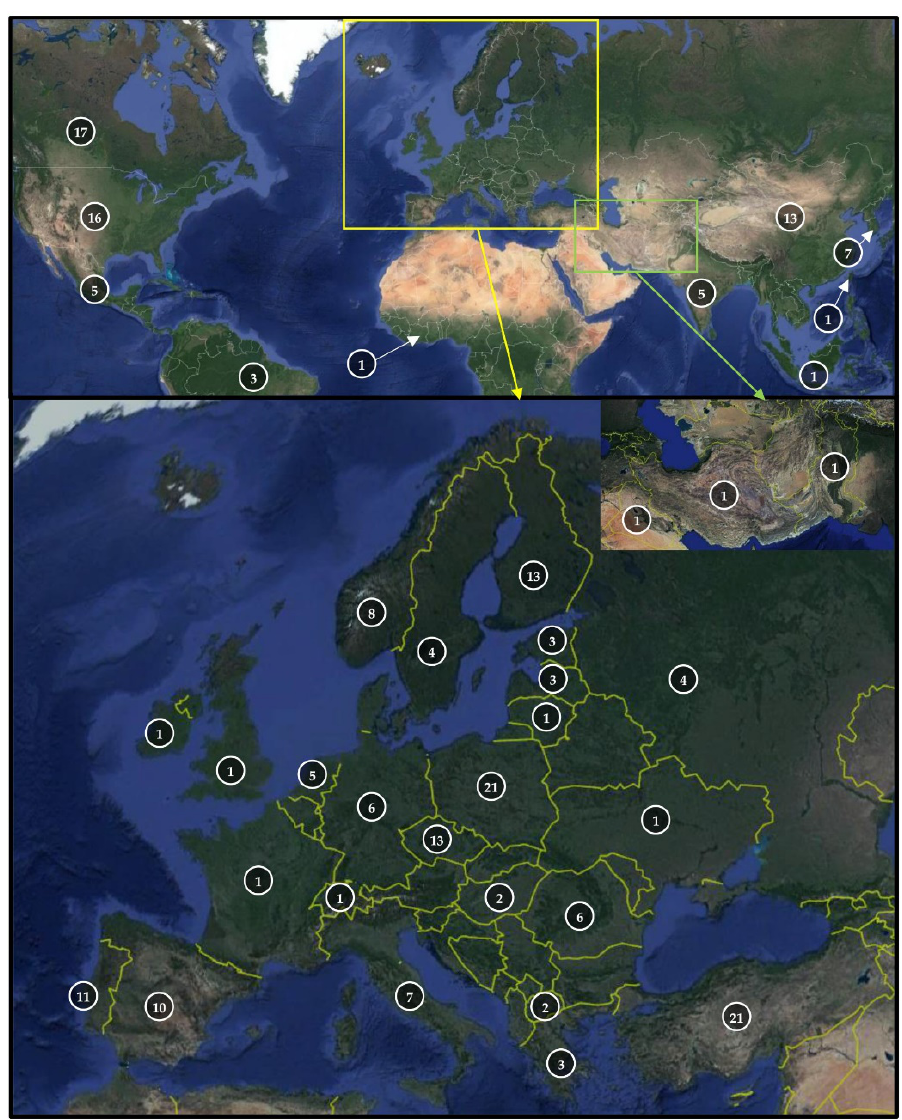
Figure 3. Number of published manuscripts from individual countries.